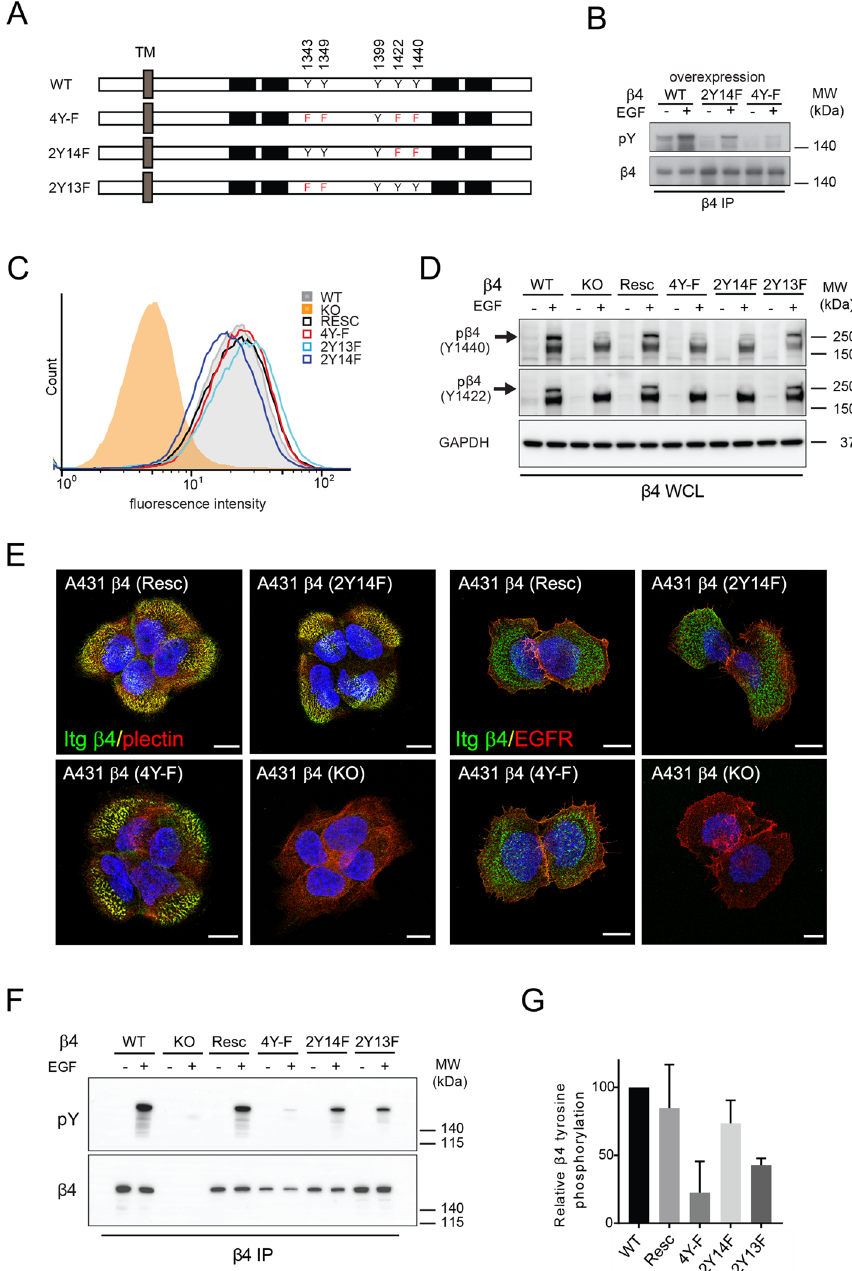
Figure 2. β4 phosphorylation occurs abundantly on the β4 CS. ( A ) Representation of the tyrosines (Y) present and mutated to phenylalanines (F) in the connecting segment (CS) of the various β4 mutants (4Y-F, 2Y14F and 2Y13F) and wild type (WT) β4. ( B ) EGF-induced β4 tyrosine phosphorylation of β4 tyrosine mutants shown by Western blot analyses of β4 immunoprecipitation (IP) samples of EGF-treated and untreated COS7 cell overexpressing WT or mutant β4 together with the EGFR. Blots were probed for β4 and phospho-tyrosine (pY). ( C ) Comparable β4 surface levels in A431 cell lines analyzed by FACS. The A431 cell lines analyzed are as follows: WT, expressing endogenous β4; KO, depleted of endogenous β4 by CRISPR-Cas9; Resc, β4 (KO) cells reconstituted with WT β4; 4Y-F, 2Y13F and 2Y14F β4 mutants, β4 (KO) cells reconstituted with mutated β4. ( D ) Representative Western blot analyses of WCLs of the various A431 cells for phosphorylation of β4 at Y1440 and Y1422 using phosphosite-specific antibodies. Cells were untreated or treated with EGF for 5 min after 20 h serum starvation. ( E ) Double immunofluorescence staining for β4 and plectin, and β4 and the EGFR in A431 β4 (KO) cells and β4 (KO) cells reconstituted with WT β4, 4Y-F or 2YF14 β4. Scale bars: 10 µm. ( F ) Representative Western blot analyses of β4 tyrosine phosphorylation and total β4 levels in β4 IP samples obtained from the various A431 cells untreated or treated with EGF for 5 min after 20 h serum starvation. ( G ) Quantification of β4 tyrosine phosphorylation levels in the various A431 cell lines, per sample normalized to total β4 levels and per experiment to the pY/β4 WT levels. Graphs shows the mean + SD from 3 independent experiments. Uncropped images of western blots, and merged chemiluminescent and colorimetric blots obtained with a ChemiDoc imaging system (BioRad) are shown in Suppl. Fig.